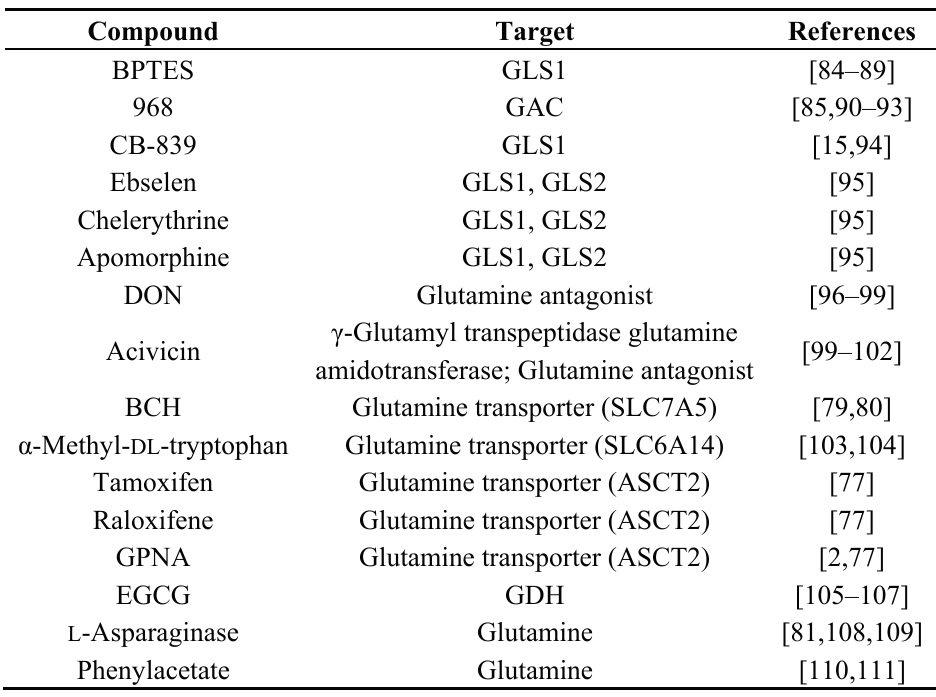
Table 1. Compounds targeting glutamine metabolism in cancer